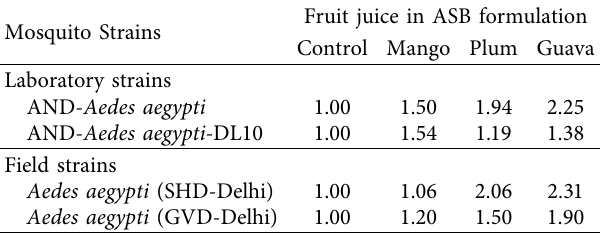
Table 3: Relative attractant efficacy ∗ of the three ASBs with respect to control against laboratory and field strains of Aedes aegypti in the postscreening